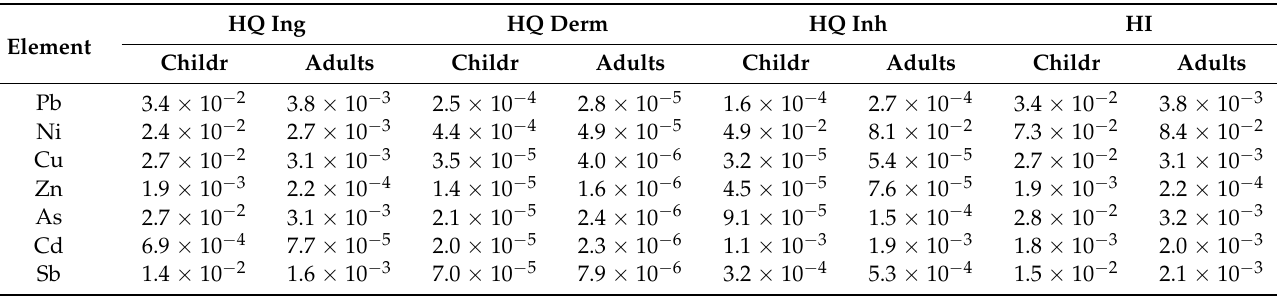
Table 7. Non-carcinogenic hazard quotient (HQ) and hazard index (HI) values of trace elements through all exposure pathways in Surgut